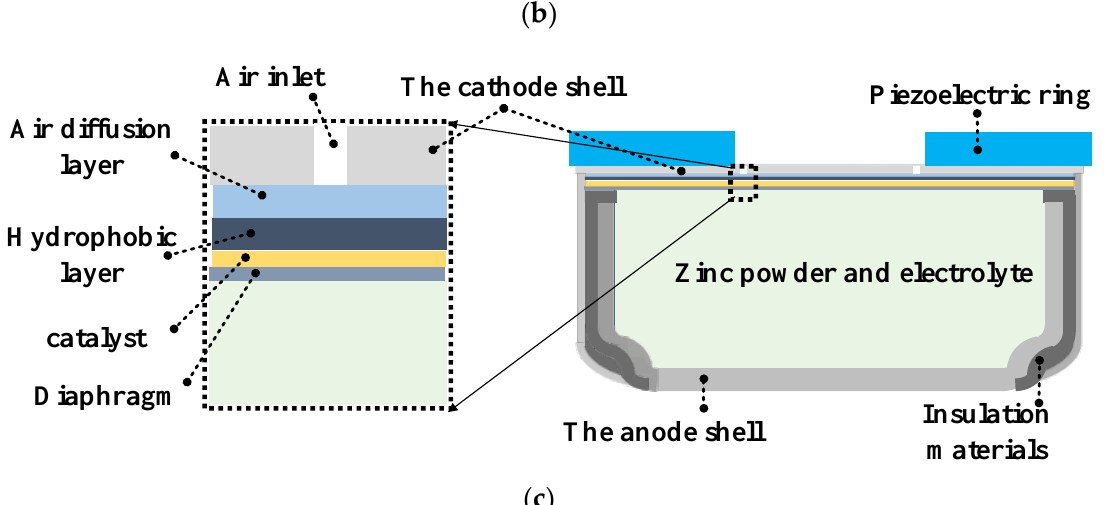
Figure 1. Photos and schematic of the button zinc – air battery with a piezoelectric ring. ( a ) Front view. ( b ) Back view. ( c ) Structural schematic.